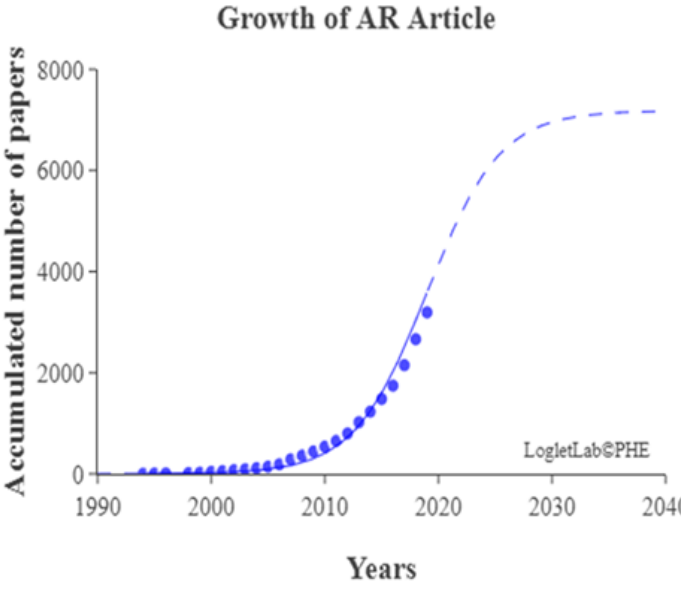
Figure 4. Growth curve of the numbers of papers.